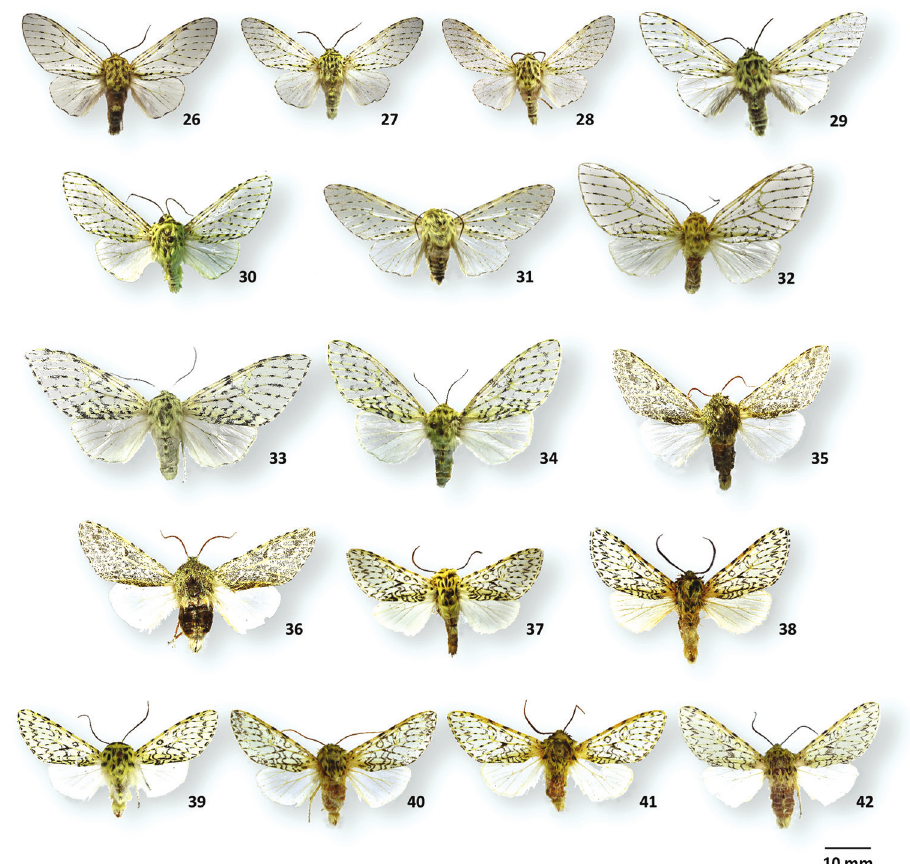
Figures 26–42. Adult habitus of Gaujonia , Gaujoptera , and Millerana species 26 Gaujonia arbosi , ♂ , MGCL, Napo, Ecuador 27 G. bichu , ♂ , holotype, FSU, Zamora-Chinchipe, Ecuador 28 G. bichu , ♂ , para- type, FSU, Loja, Ecuador 29 G. chiqyaq , ♂ , paratype, MGCL, Marinio, Colombia 30 G. kanakusika , ♂ , holotype, MGCL, Cundinamarca, Colombia 31 G. sourakovi , ♂ , holotype, MGCL, Cusco, Peru 32 G. ar- bosi , ♀ , MGCL, Napo, Ecuador 33 G. chiqyaq , ♀ , holotype, MGCL, Marinio, Colombia 34 G. kanakusi- ka , ♀ , paratype, MGCL, Cundinamarca, Colombia 35 Gaujoptera amsa , ♂ , holotype, MGCL,